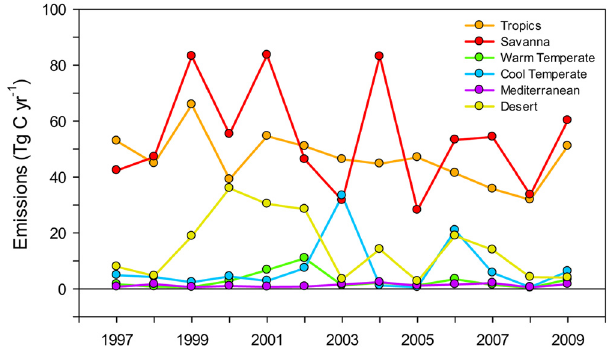
Fig. 12. Annual time series of GFED CO 2 -C gross fire emissions by bioclimatic region.